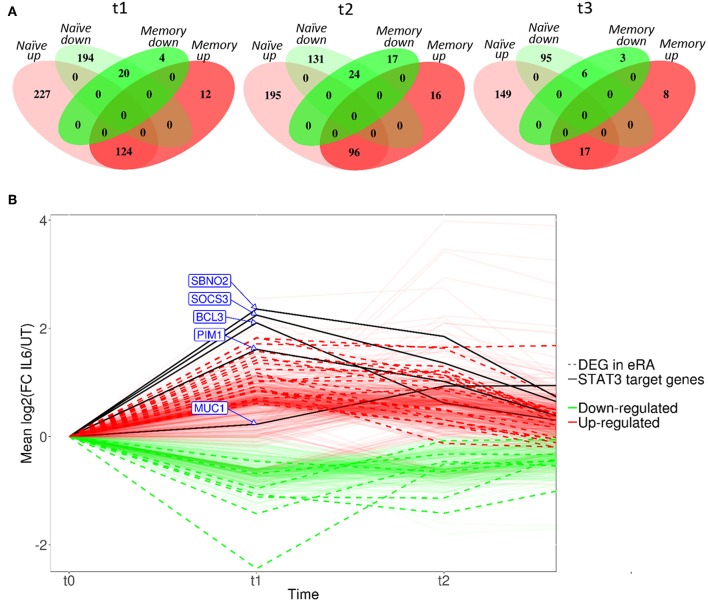
(A) Venn diagrams showing the number of differentially expressed genes between untreated and IL-6 pre-exposed naïve and memory CD4+ T cells isolated from 3 healthy donors at t1–t3 using a moderated paired t-test with fold change of 1.5 and Benjamini-Hochberg adjusted p-value of <0.05. (B) Dynamic profiles of genes significantly dysregulated at indicated time-points amongst naïve CD4+ T-cells. Fold- expression in IL-6 exposed cells is depicted relative to that in non-exposed cells at each time-point (FC > 1.5, corrected p < 0.05 for inclusion). Genes previously observed to be differentially expressed (DE) in early RA (eRA) are indicated (heavy lines), and specific STAT-3 targets labeled (solid lines), FC, fold-change in expression, see text.